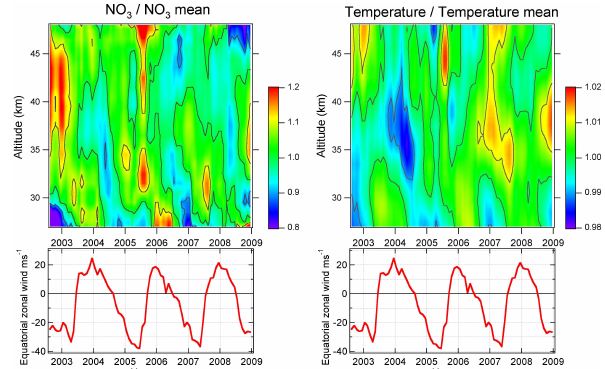
Fig. 4. Top) Evolution of O 3 and NO 2 mixing ratios in the latitude band 15 ◦ S–15 ◦ N divided by their mean value at the given altitude for the full period; Bottom) Equatorial zonal wind at 10hPa updated from Naujokat (1986).